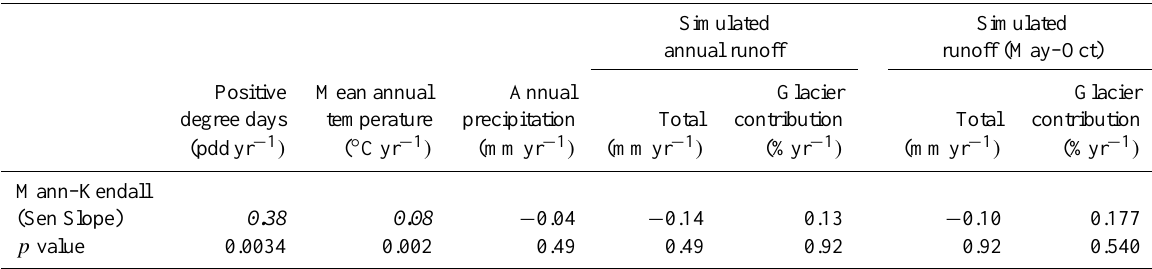
Table 4. Trend statistics and trend slopes computed with the Sen’s slope estimator for the time period 1980–2007. Slopes of statistically significant trends are in